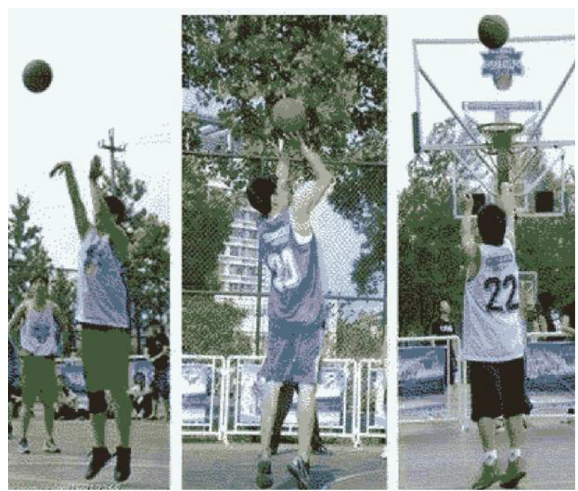
Table 3: Details of male and female basketball players.